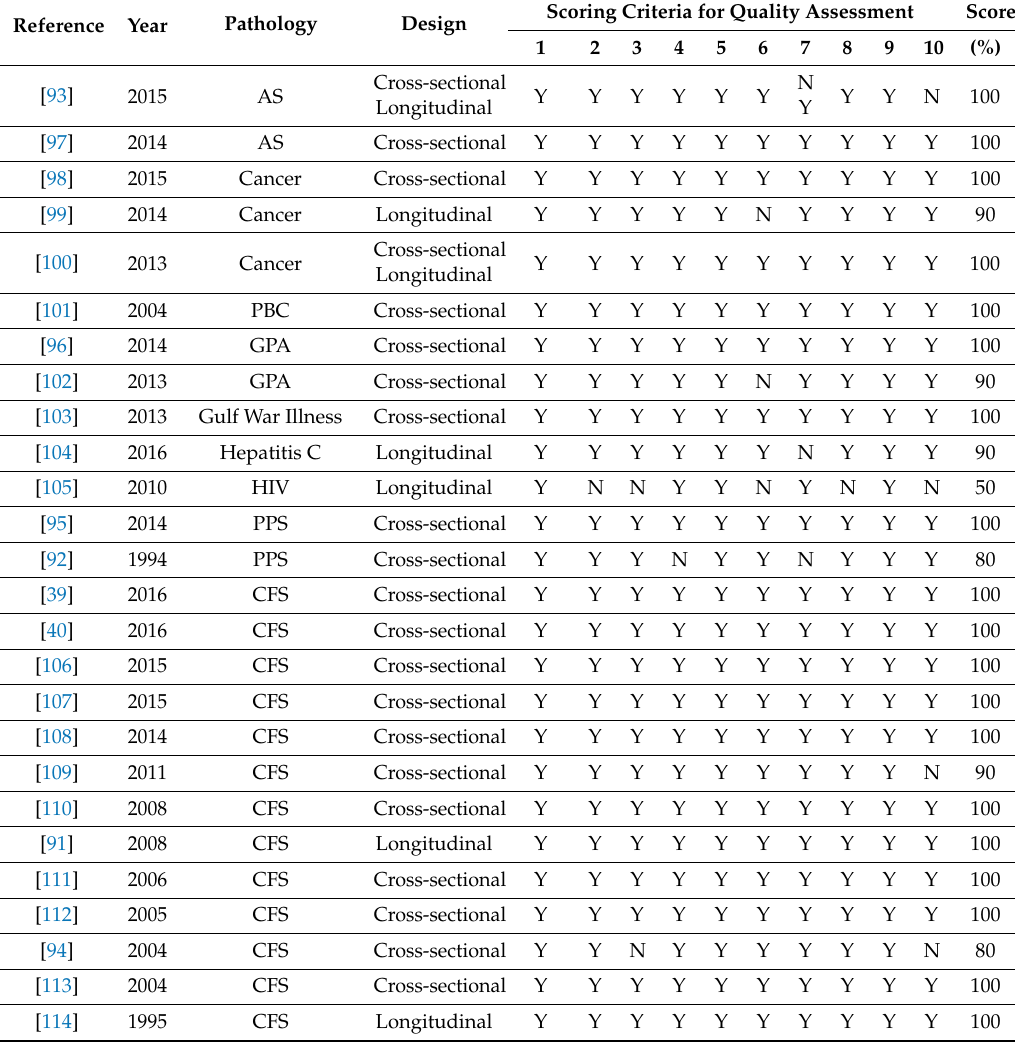
Table 2. Quality assessment of included